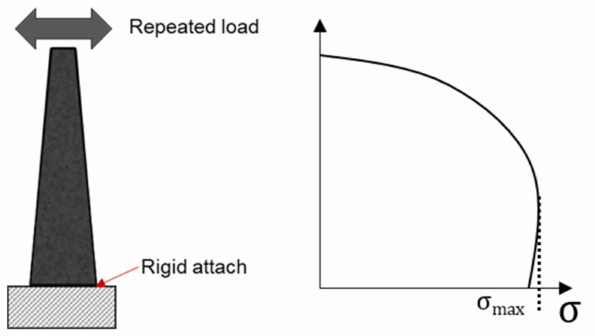
Figure 5. Schematic diagram and tensile stress distribution of 2PB fatigue